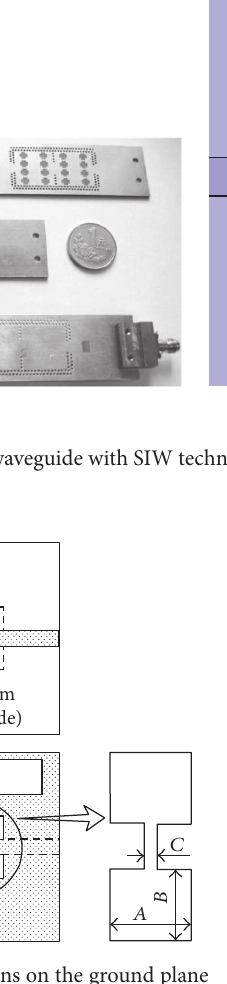
Figure 24: Microstrip line with DGS patterns on the ground plane at the output of the power amplifier ( A = 2: 8mm, B = 2 : 5mm, and C = 0: 5mm) [70].